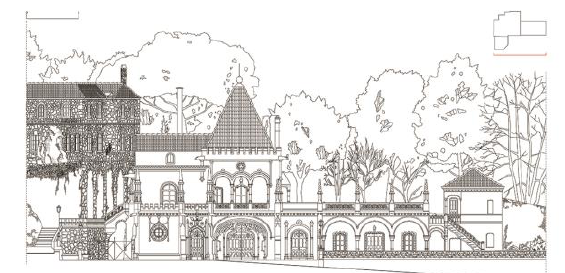
Figure 2 . The Quinta da Regaleira in Sintra, the Chocheiras , main